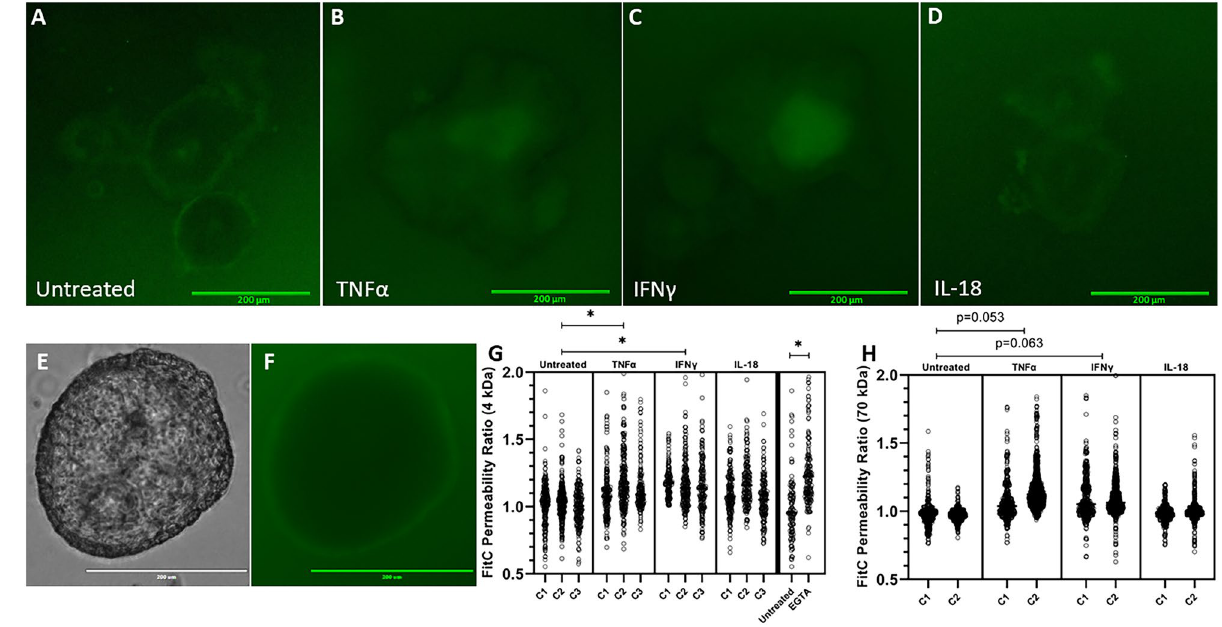
Figure 3. Cytokine treatment increases bovine intestinal organoid barrier permeability, as measured by FITC Dextran permeability. ( A–D ) Representative images of bovine intestinal organoids exposed to 4 kDa FITC Dextran following 24 h cytokine treatment acquired using a ×10 objective lens and GFP (470/525 nm ex/em) LED light cube. Scale bars denote 200 µm. ( E,F ) Representative images of an untreated enteroid following 70 kDa FITC Dextran exposure collected using a ×20 objective lens and brightfield or GFP LED light cube. Scale bars denote 300 µm. ( G,H ) Luminal FITC intensity normalized to external FITC intensity following 24 h cytokine treatment or two-hour treatment with 2 mM EGTA as a positive control. C1, C2, and C3 indicate individual enteroid lines. Nested ANOVA (α = 0.05) determined a significant effect of treatment was present for both 4 kDa and 70 kDa FITC Dextran (p = 0.0097 and p = 0.039, respectively). TNFα and IFNγ increase 4 kDa FITC Dextran permeability (p = 0.0257, p = 0.0132, respectively) as determined by Holm-Šídák post hoc analysis. EGTA, a positive control, increases FITC Dextran permeability (p < 0.0001) determined by one-tailed Mann– Whitney non-parametric test (α = 0.05). Holm-Šídák post hoc analysis for 70 kDa FITC Dextran displayed trending, but not significant, effects of TNFα and IFNγ treatment (p = 0.052 and p = 0.063,